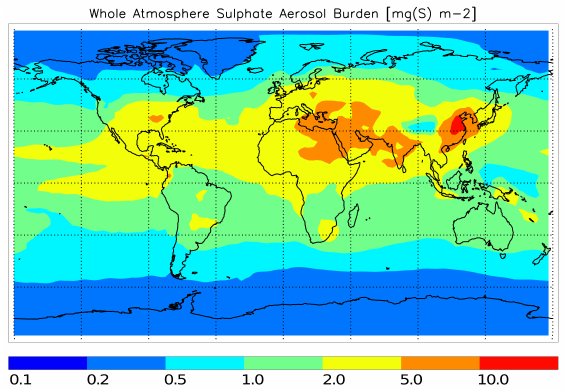
Fig. 5. Global distribution of the modelled annual mean of sulphate aerosol burden in the last year of